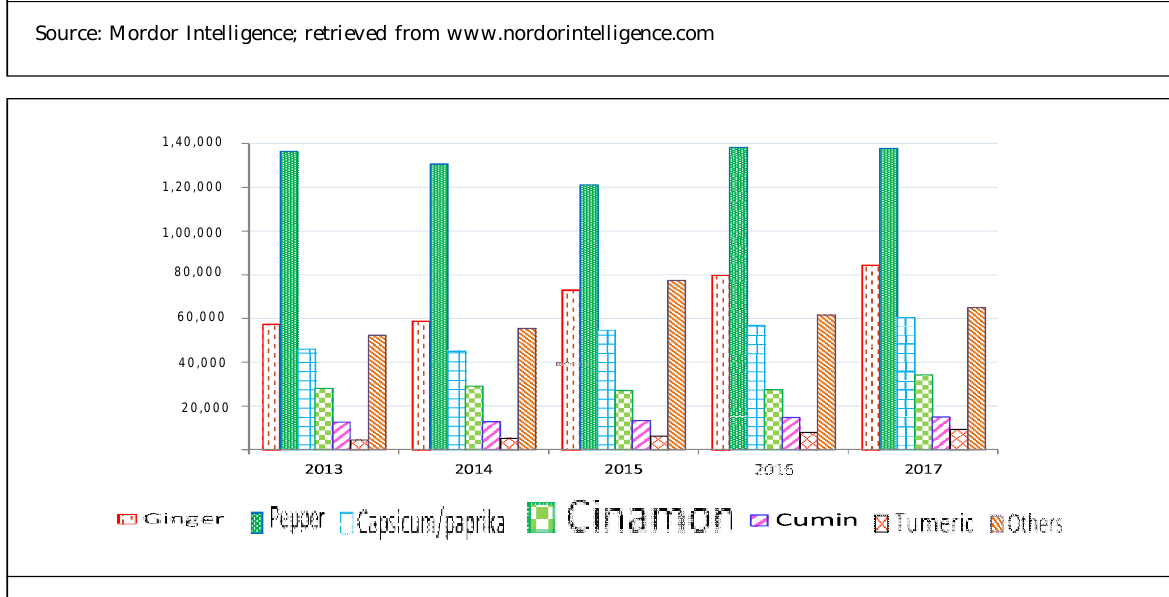
Figure 2: The US import quantity (MT) of the top spices during a five-year period 2013-2017 Source: The United State Department of Agriculture, Foreign Agricultural Service (USDA